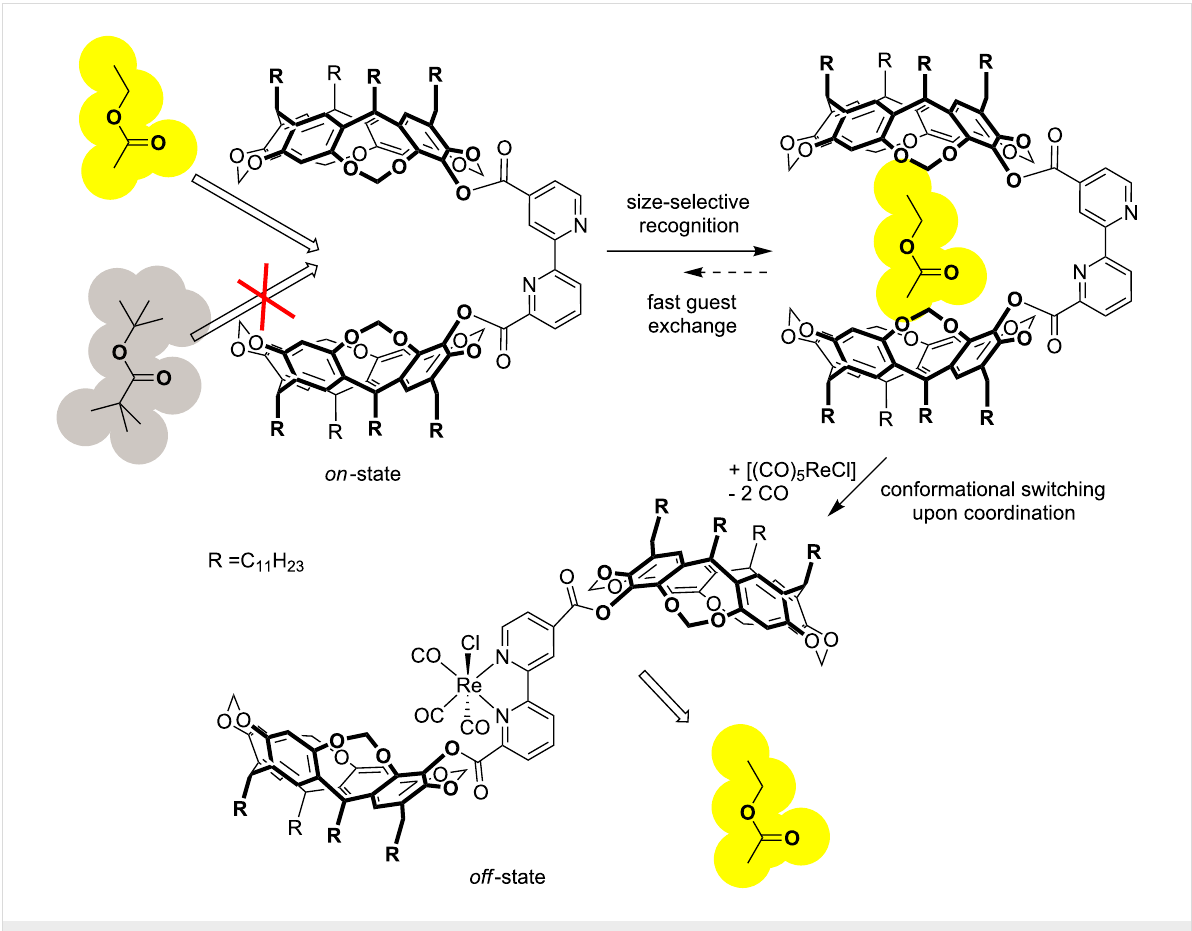
Scheme 3: Binding model of the negative cooperative allosteric behaviour of 2